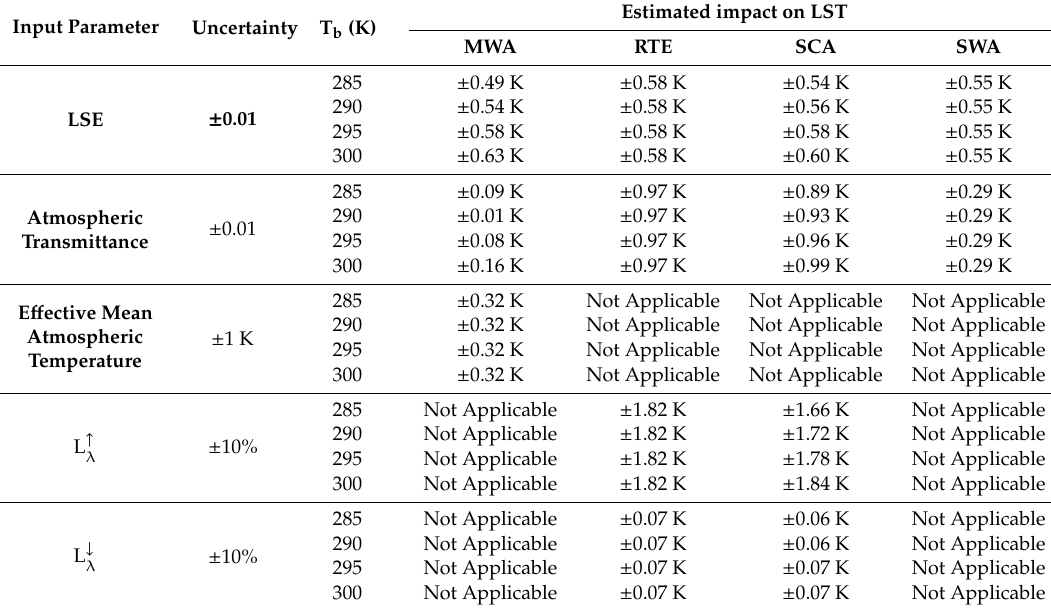
Table A5. Sensitivity of the LST retrieval methods to the input